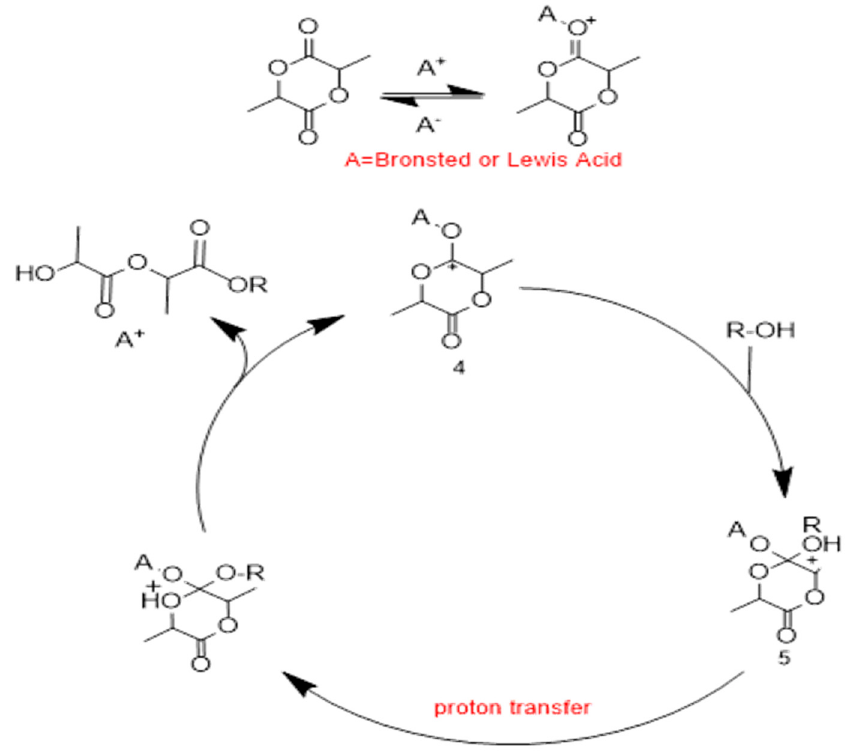
Scheme 4. Activated monomer mechanism for ROP of lactide